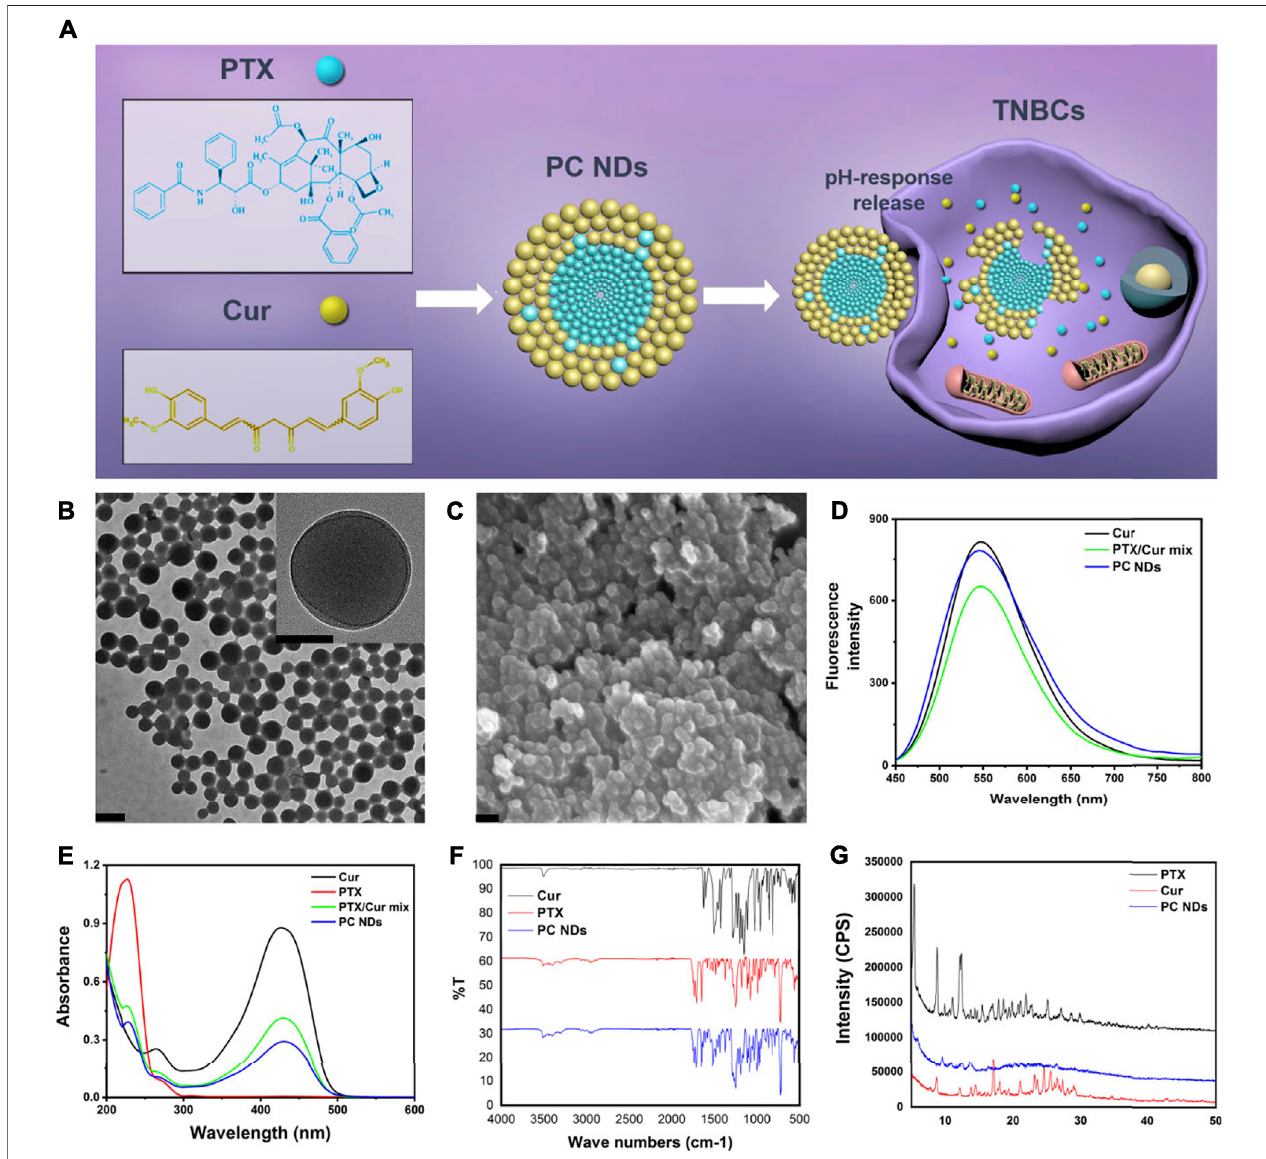
FIGURE 1 | Scheme of PC NDs preparation and its characterization. (A) Scheme of PC NDs preparation. PC NDs has been prepared using a reprecipitation method and shown pH-sensitive drug release behavior in tumor cells. (B) TEM images of PC NDs. Scale bars are 200 and 50 nm (inset), respectively. (C) SEM image